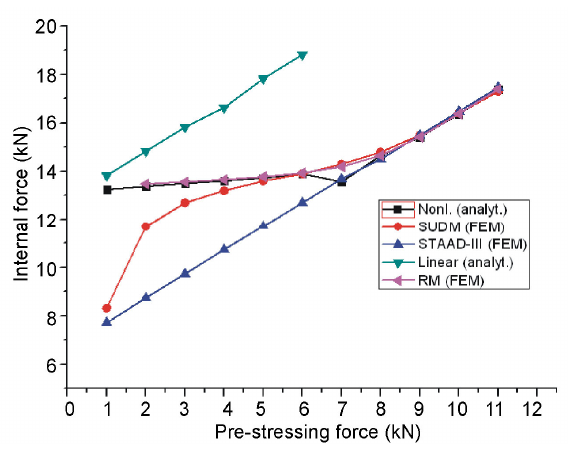
Fig. 4. Graph of general internal force vs